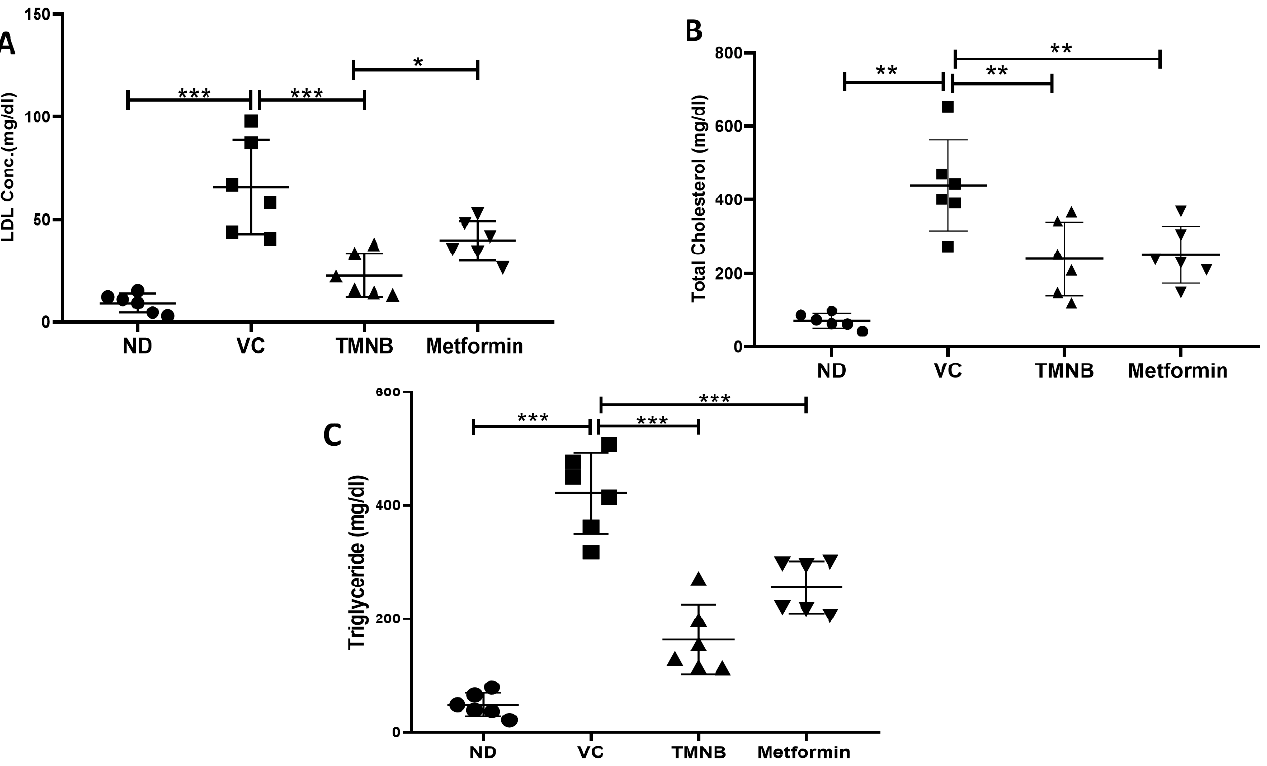
Figure 6. 2 (cid:48) ,3,3,5 (cid:48) -Tetramethyl-4 (cid:48) -nitro-2 (cid:48) H-1,3 (cid:48) -bipyrazole improves lipid profile in diabetes. TMNB significantly reduced LDL ( A ), cholesterol ( B ), and triglyceride ( C ) systemic concentrations in diabetic rats. Rats were fed HFD for 3 weeks, followed by a single dose of STZ injection (40 mg/kg); and once diabetes was confirmed, rats were treated with 10 mg/kg TMNB or 200 mg/kg metformin for 10 days. At the end of the experiment following euthanasia, serum was collected for ELISA analyses. One-way ANOVA was followed by Tukey post-hoc multiple comparison test, * < 0.05, ** < 0.01, *** < 0.001. ND; non-diabetic, VC; vehicle control, TMNB; 2 (cid:48) ,3,3,5 (cid:48) -Tetramethyl-4 (cid:48) -nitro-2 (cid:48) H-1,3 (cid:48) - bipyrazole.